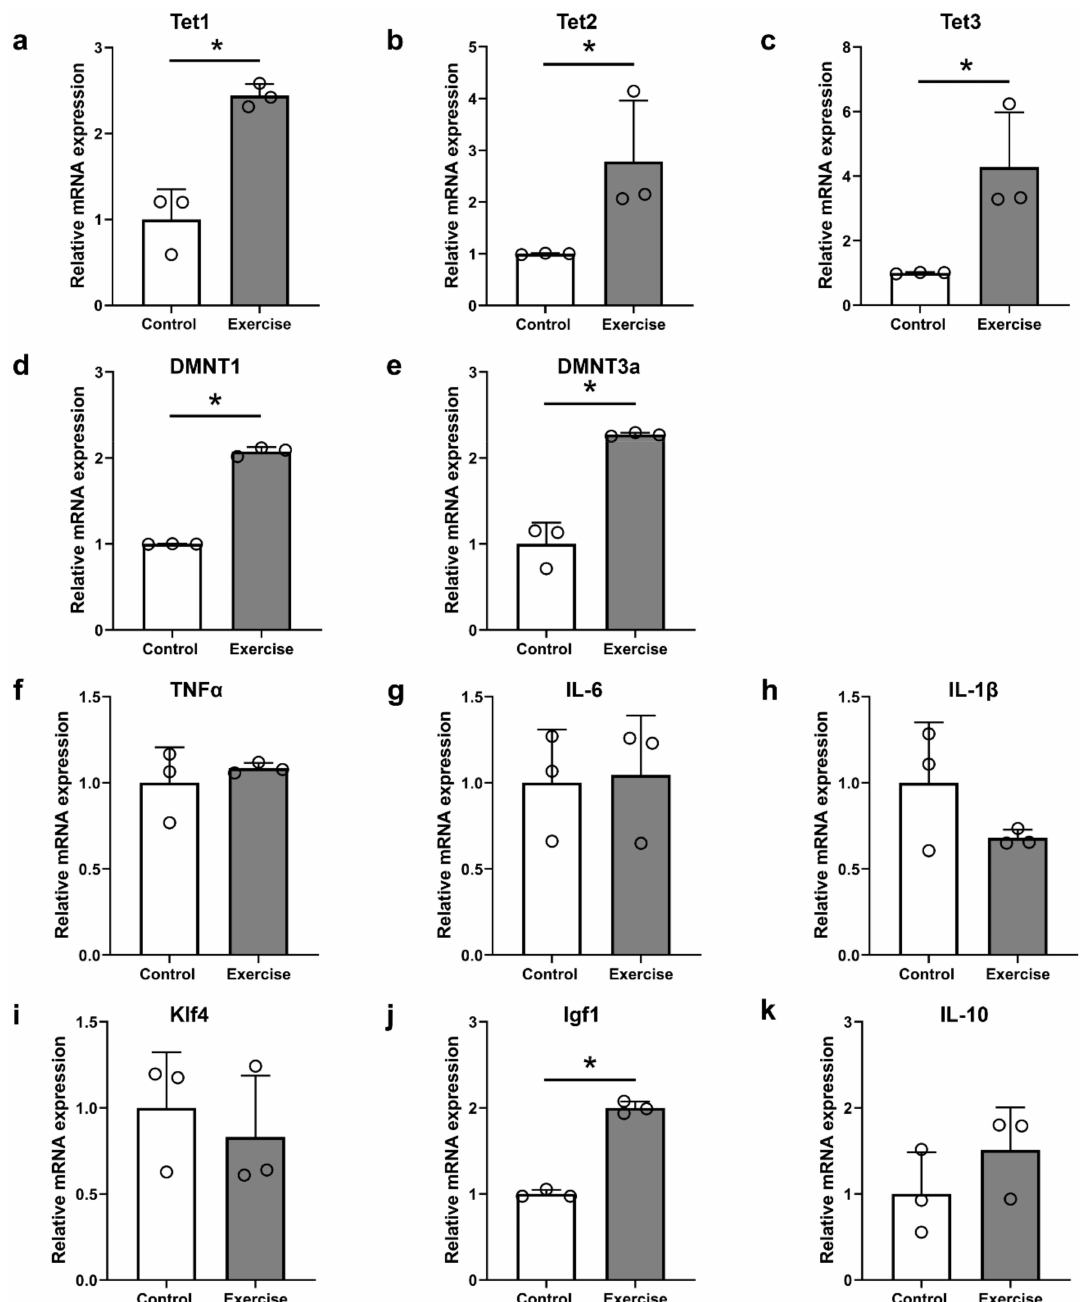
Figure 7. Real-time PCR analysis in the primary motor cortex of the control and exercise groups at 12 weeks after injury. ( a – c ) Tet family genes (Tet1, Tet2, and Tet3), ( d , e ) DNA methyltransferase genes (DNMT1, DNMT3a), ( f – h ) inflammation- related genes (TNF α , IL-6, and IL-1 β ), and ( i – k ) regeneration-related genes (Klf4, Igf1, IL-10) ( n = 3 per group). * p < 0.05 between the control and exercise groups by the Mann–Whitney U